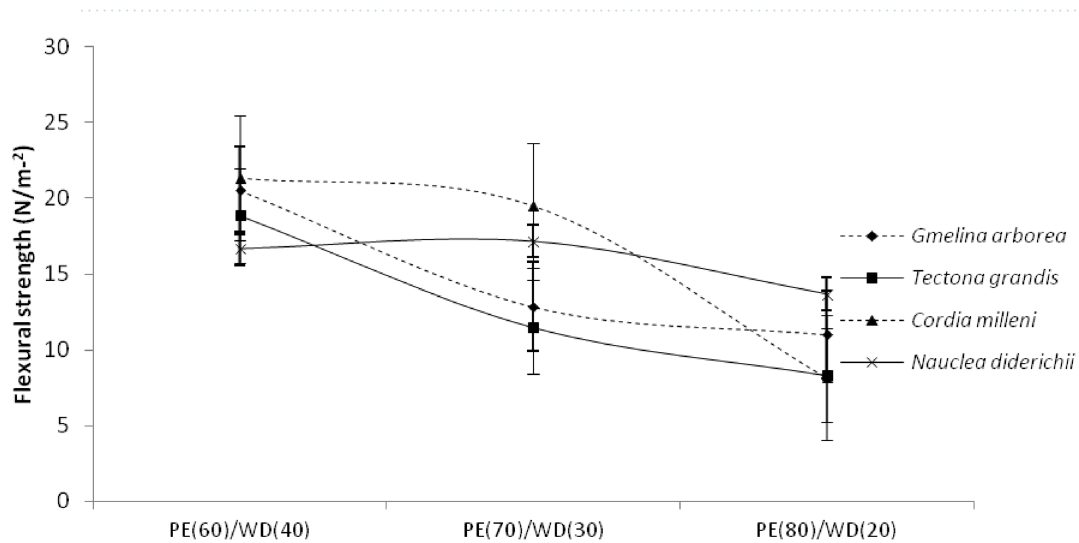
Figure 6. Flexural strength of extruded-compressed biopolymer